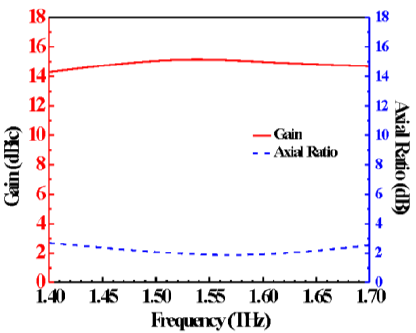
Figure 9. Simulated RHCP gain and axial ratio of the proposed reflectarray. The red and the blue curves represent the RHCP gain and axial ratio, respectively.